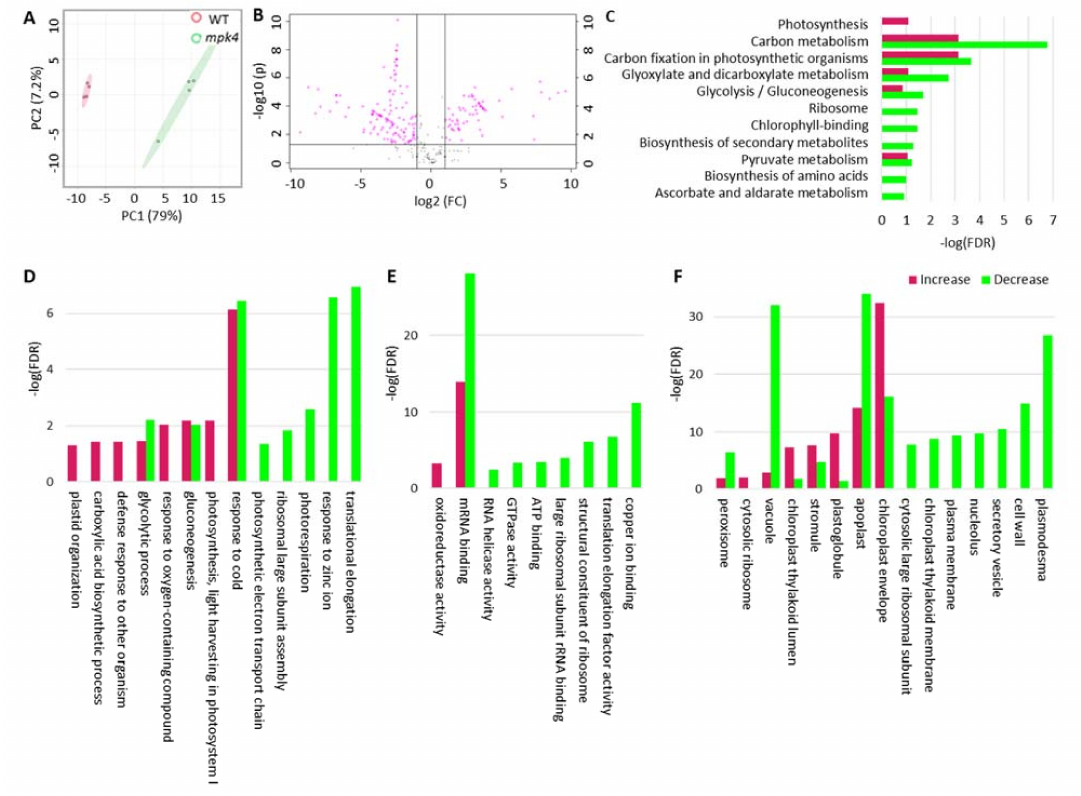
Figure 5. Proteomics data analysis of WT and the mpk4 mutant. ( A ) PCA analysis. ( B ) Volcano plot. FC (fold change) = protein level in mpk4 /WT. ( C ) KEGG pathway enrichment analysis. ( D ) GO biological process. ( E ) GO molecular function. ( F ) GO cellular